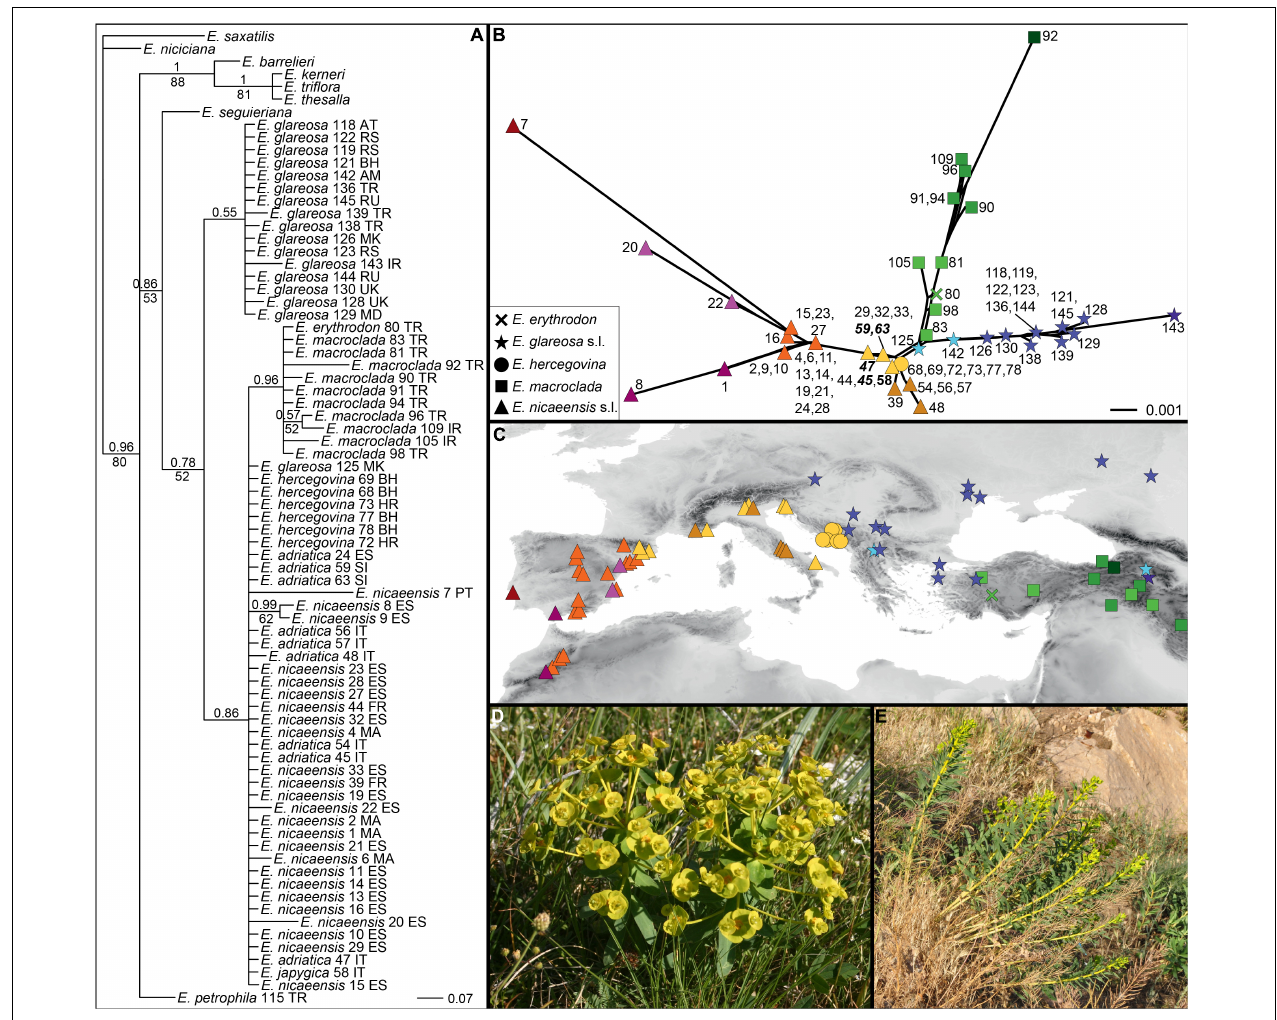
FIGURE 5 | Phylogenetic relationships within the Euphorbia nicaeensis alliance and between this alliance and its closest relatives within E. sect. Pithyusa as inferred by Internal Transcribed Spacer (ITS) sequences. (A) Bayesian consensus phylogram with posterior probabilities > 0.50 above, and parsimony bootstrap values > 50% below branches; country codes follow the accession names. (B) NeighborNet and (C) geographic position of the ITS ribotype groups revealed by the NeighborNet and indicated by different colours. Population numbers in (A,B) are presented in Supplementary Figure 1 and in Supplementary Table 1 . Population numbers of populations that are based on our revised taxonomic treatment belong to E. adriatica and are in (B) in bold italics (45, 47, 59, 63), and the one corresponding to E. japygica (58) is in bold. (D) Euphorbia adriatica from Italy and (E) E. macroclada from Turkey in their natural habitats. Photos: B. Frajman (D) , C. Gilly (E)